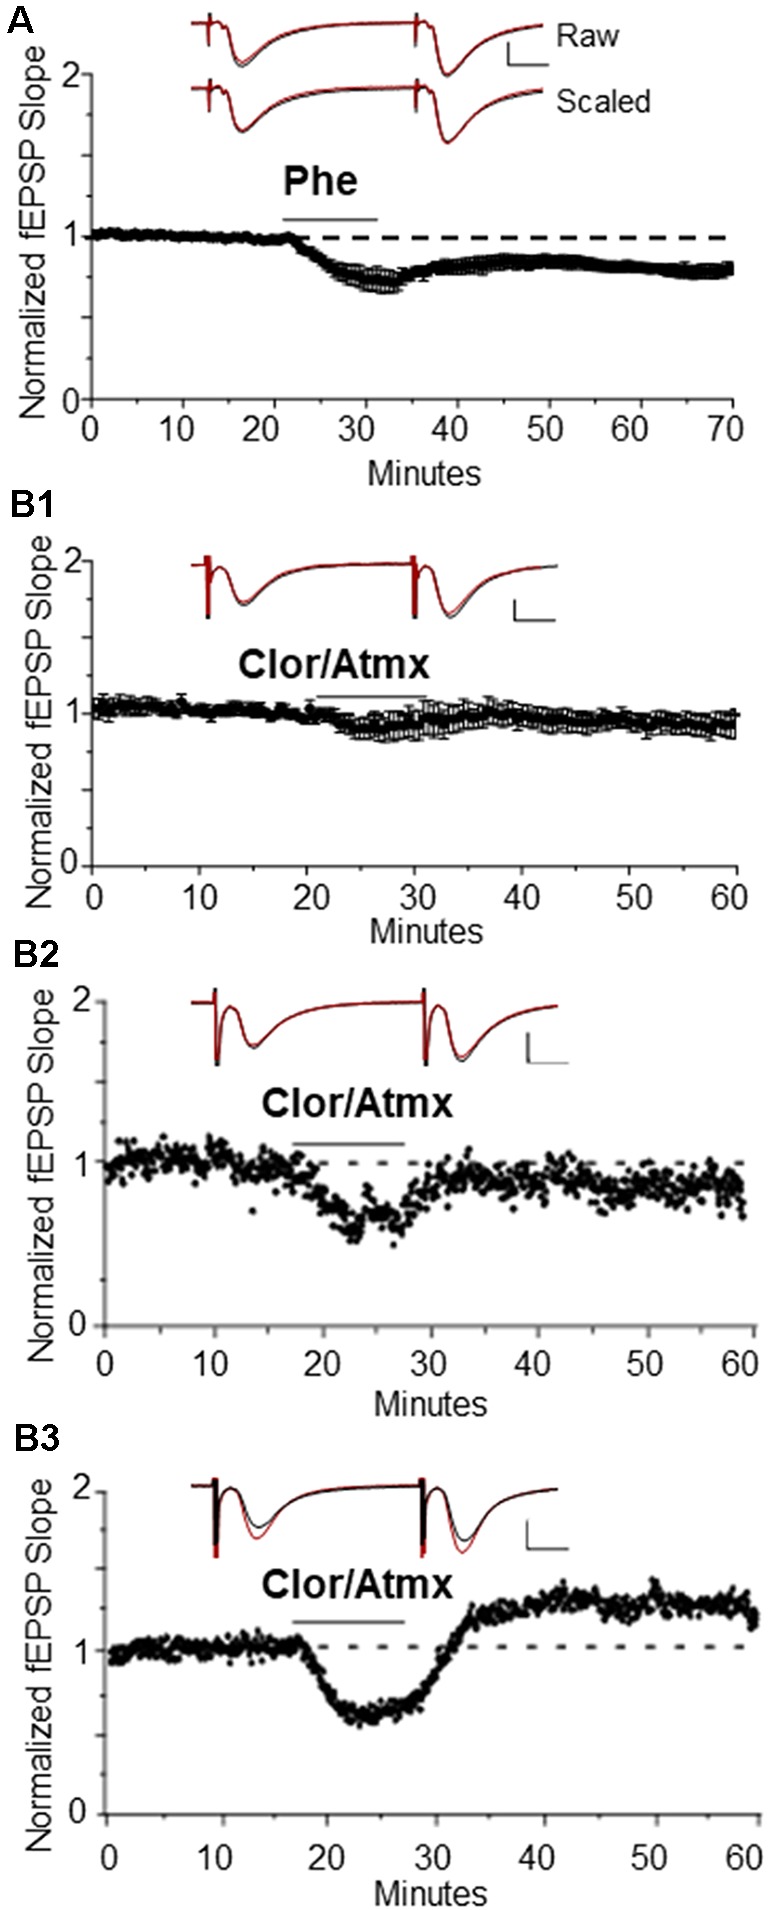
Long-term depression (LTD) is induced by the α1AR agonist, phenylephrine, or endogenous NE when β-ARs are pharmacologically blocked. (A) α1AR LTD is induced by the selective α1AR agonist Phe. One-hundred micro molar is able to induce α1AR LTD in control animals [84 ± 4% of baselined field excitatory postsynaptic potential (fEPSP) slope, n=6]. Top traces are averaged raw fEPSPs before (black) and after (red) application of phenylephrine. Bottom traces are averaged, scaled fEPSPs (red) during LTD expression overlaid onto baseline traces (black) showing no change in the pair-pulse facilitation ratio (scale bar: 0.5 mV, 10 ms). (B1) Averaged experiments in Clor/Atmx results in no significant change in baseline transmission (94 ± 5% of baseline fEPSP slope, n = 6). (B2) Representative example of LTD induced via norepinephrine transporter (NET) and monoamine oxidase (MAO) inhibition by Atmx (500 nM) and Clor (10 μM, respectively). (B3) Single example of LTP induced via endogenous NE accumulation in the presence of Clor/Atmx.